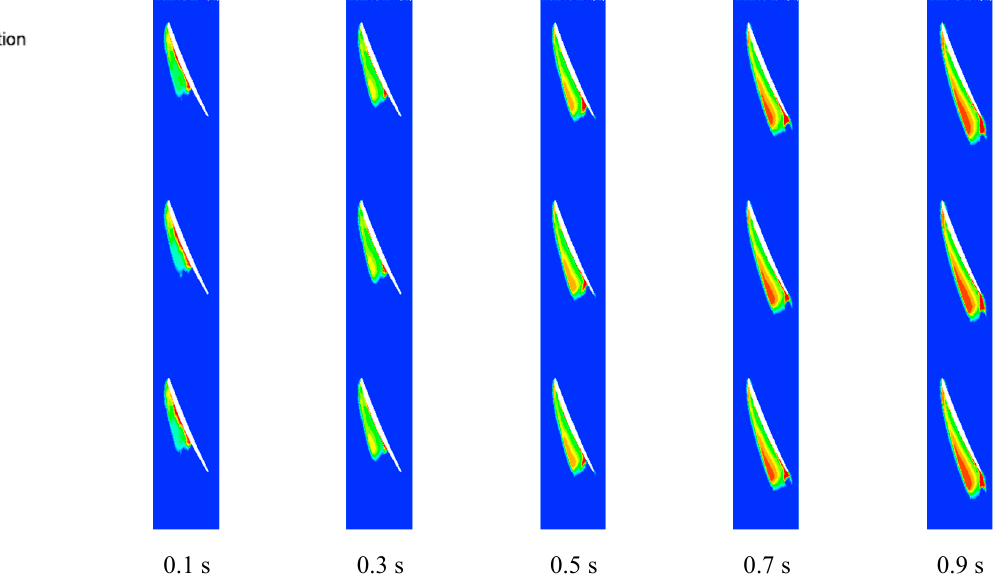
Figure 9. Expansion of cavitation cloud diagram on the blade